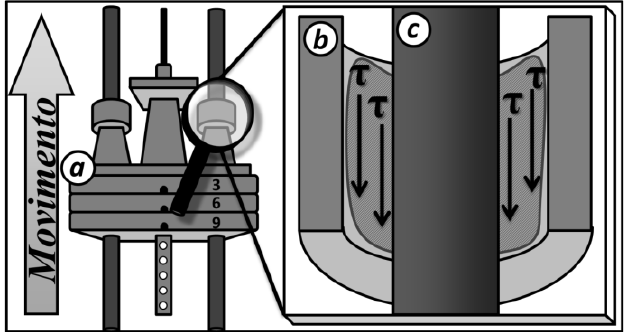
Figura 7. Imagem esquemática: a letra ( a ) indica a Pastilha Móvel de Carga, a seta à extrema esquerda indica o sentido e a direção do seu movimento; ( b ) indica a guia que orienta esse movimento no trilho, o qual é indicado pela letra ( c ). O zoom ilustra a interação entre o fluido lubrificante (área sombreada) e os componentes da máquina, indica a tensão de cisalhamento procedente da viscosidade do fluido, esses componentes ( b e c ) se mantêm muito próximos (cerca de 0,3 cm) e a quantidade de fluído lubrificante é bastante pequena, o que a torna sua ação também pequena, porém não desprezível. De acordo com as leis dos fluidos newtonianos, quanto maior a velocidade do corpo (neste caso o corpo em questão é o b ) que